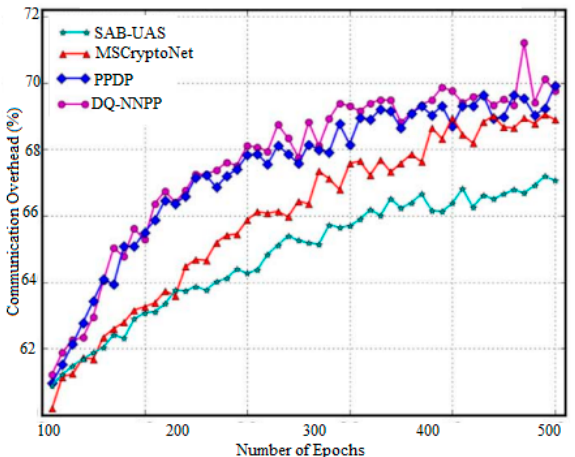
Figure 7. Comparison of communication overhead.